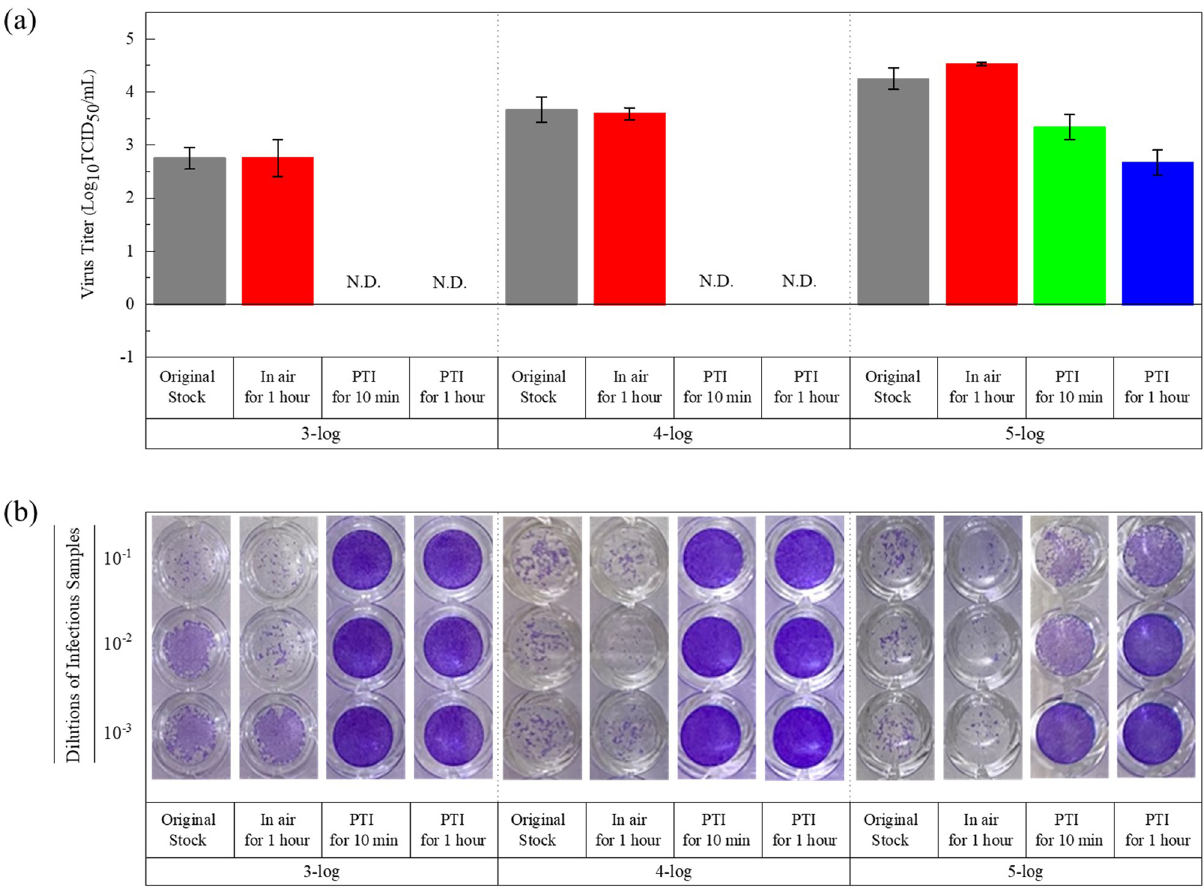
Figure 6. Assessment of the titer of the H1N1pdm09 virus with respect to the viral doses (or concentrations) and inactivation times. ( a ) Results of the TCID 50 assay, and ( b ) Photographs of the crystal violet staining of the MDCK cells with respect to the dose of the virus stock, the exposure time of PTI. Prime/probe Sequence (5 ′ -3 ′